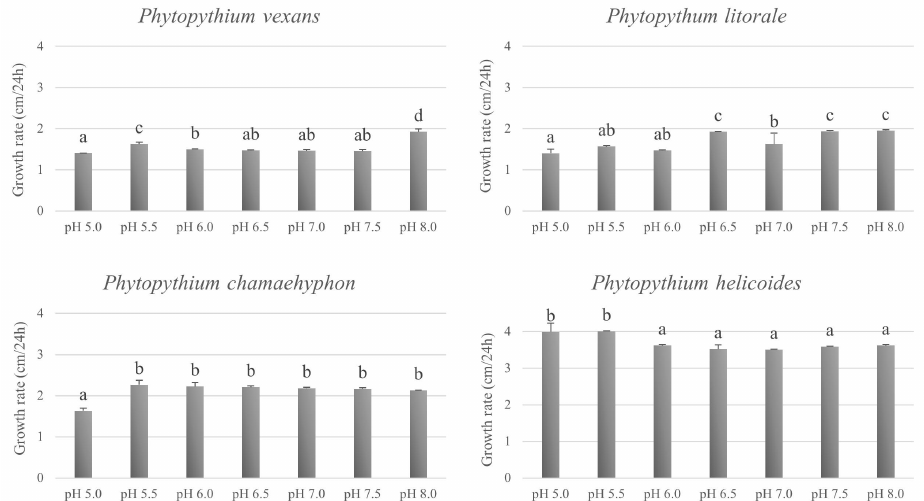
Figure 5. Average radial growth rate (cm/24 h) of two strains per Phytopythium species grown onto PCA media adjusted at specific pH at 25 °C for 5 days. Values are expressed as mean values ± SD (n = 6). Values followed by the same letter are not statistically different by Tukey’s test ( p ≤ 0.05).